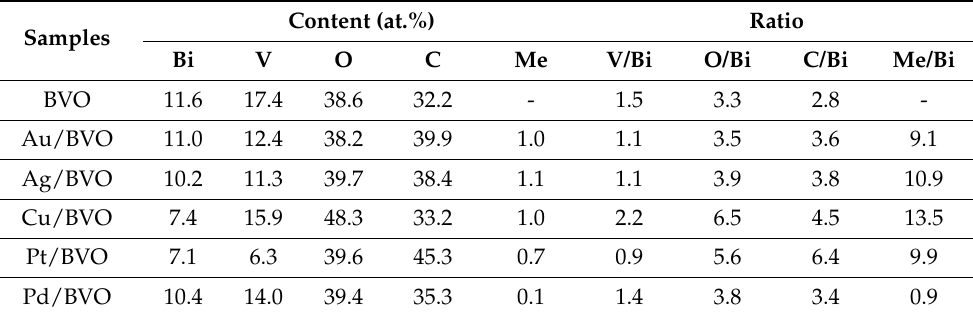
Table 2. Fraction of oxidation states of Au, Ag, Cu, Pt and Pd from deconvolution of XPS peaks of